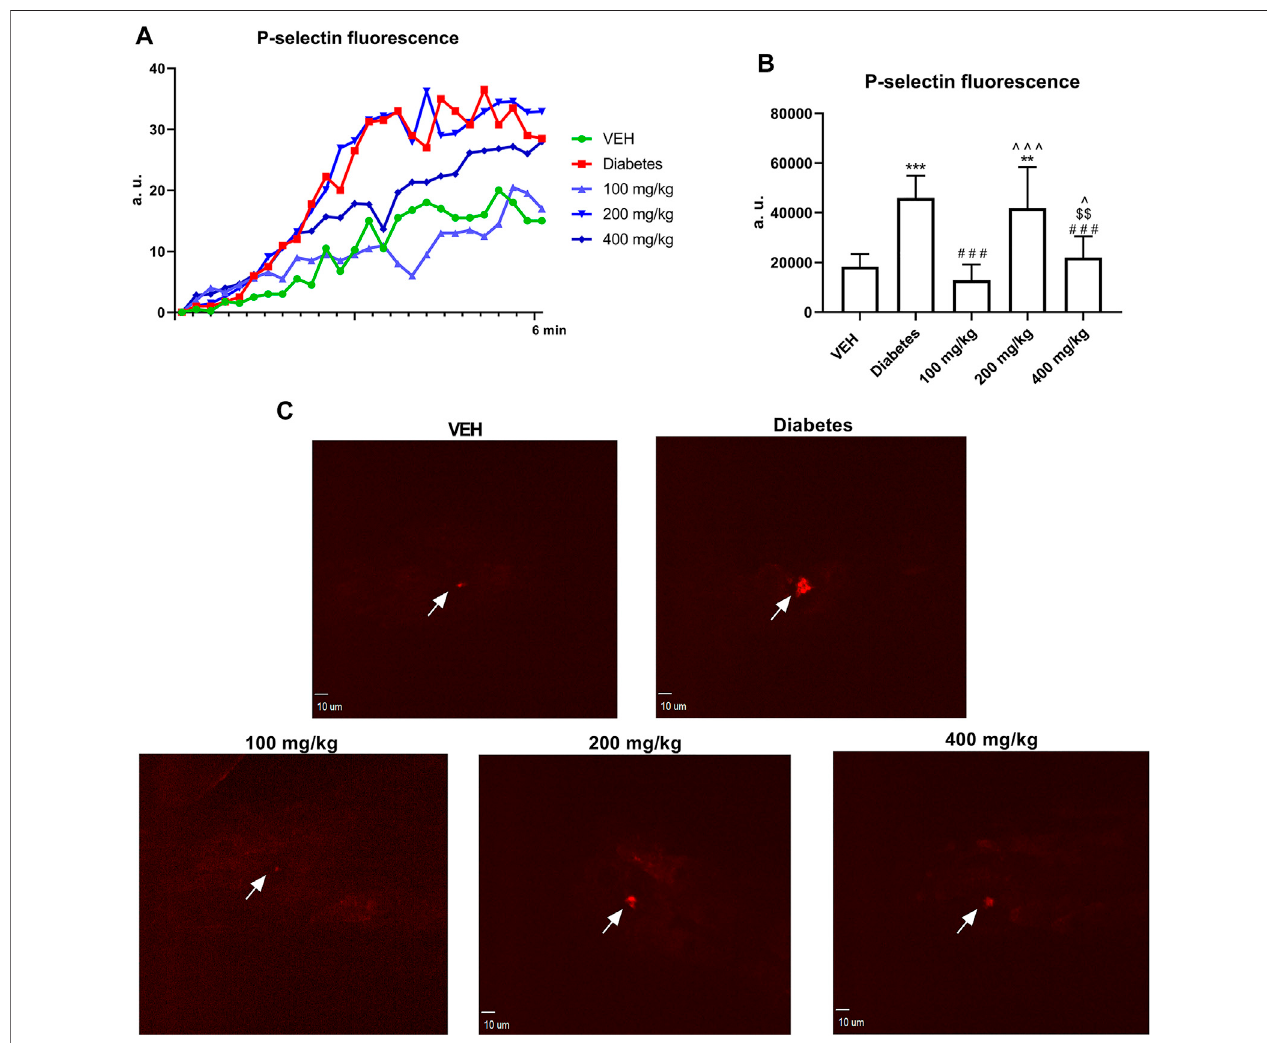
FIGURE6| ChangesinP-selectin fl uorescence at thesiteofinjury. Fluorescence ofP-selectinispresentedinarbitrary units of fl uorescence (a.u.) (A) .Theeffect of TEonP-selectinsecretionbyplatelets (B) .RepresentativeconfocalmicroscopyimagesofP-selectin.Whitearrowsindicatethesiteofinjury.Bar (cid:2) 10 µm (C) .** p < 0.01, *** p < 0.001 vs. VEH; ### p < 0.001 vs. Diabetes; ^ p < 0.05, ^^^ p < 0.001 vs. 100 mg/kg; $$ p < 0.01 vs. 200 mg/kg, n (cid:2) 8 – 9. Data are shown as mean ±